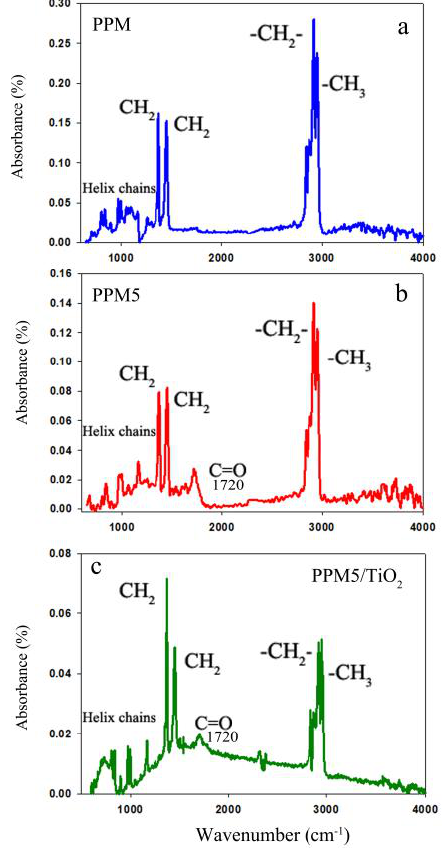
Figure 5. Attenuated total reflection- Fourier transform infrared spectroscopy (ATR-FTIR) spectrum of PPM ( a ), PPM5 ( b ) and PPM5/TiO 2 ( c ).